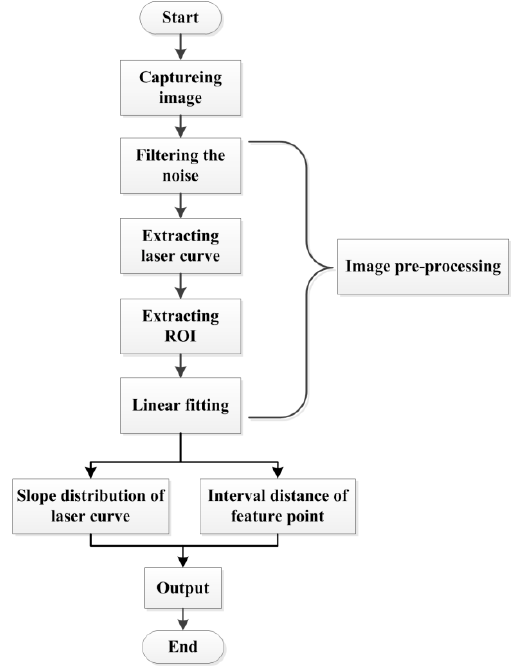
Figure 6. Features extraction process of a weld joint image.